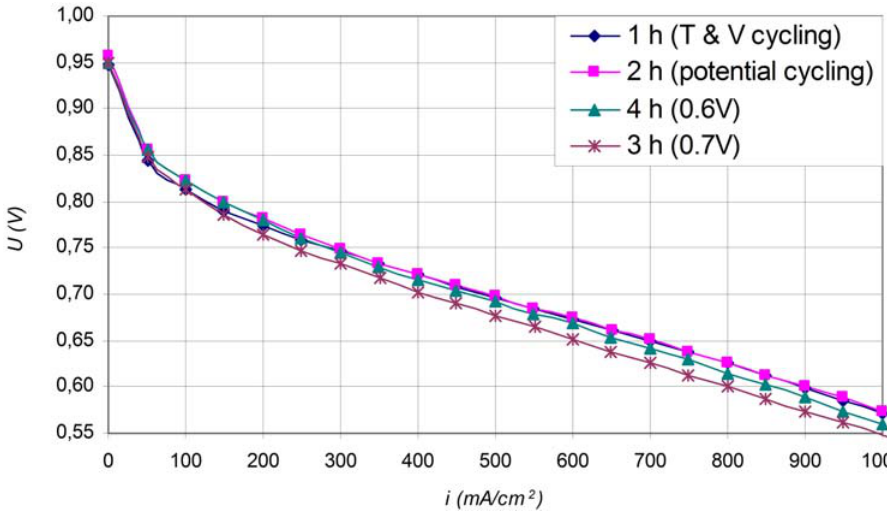
Fig. 4. Final polarization curves after different initial conditioning